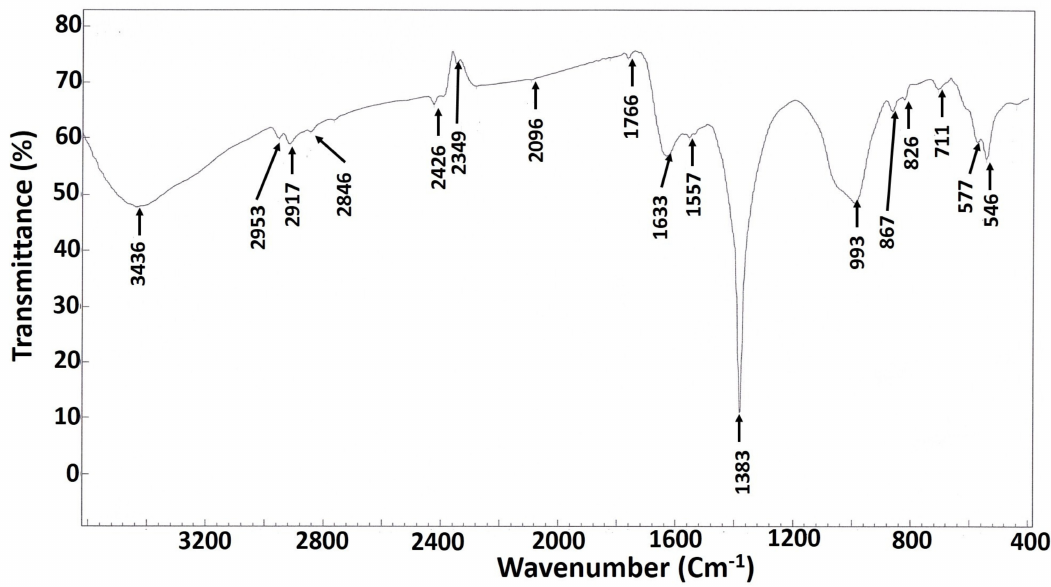
Figure3. Fouriertransforminfrared(FT-IR)spectrumoftheAg-NPsderivedfromendophytic S.laurentii